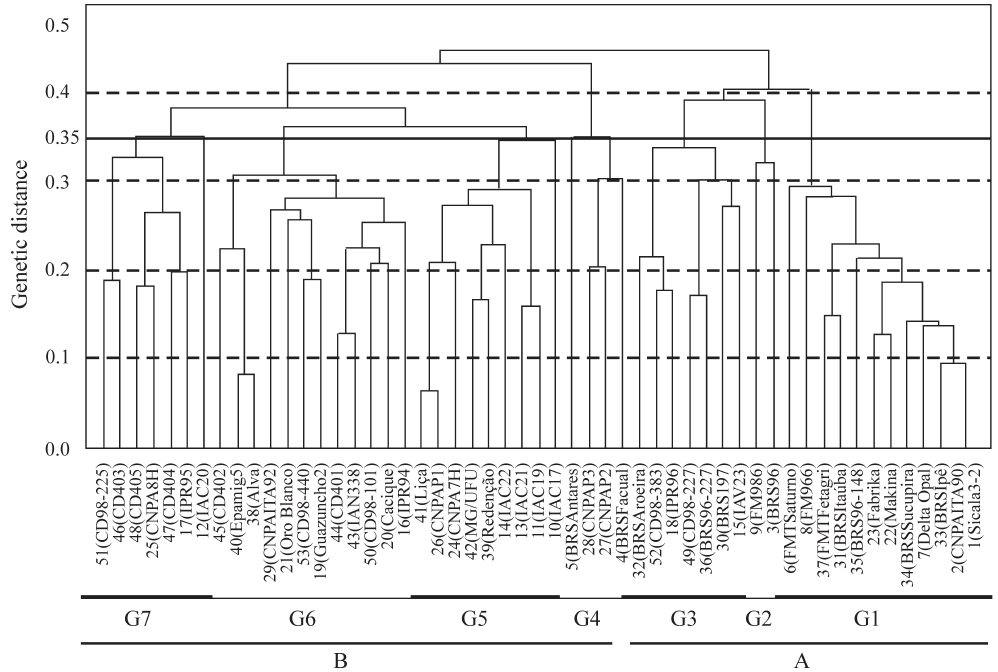
Figure 2 - UPGMA dendrogram constructed based on dissimilarities measures of 53 cotton cultivars. Groups A and B were obtained considering an up- per dissimilarity limit of 50% while the G1, G2, G3, G4, G5, G6 and G7 subgroups shown below the figure were obtained considering an upper-limit of